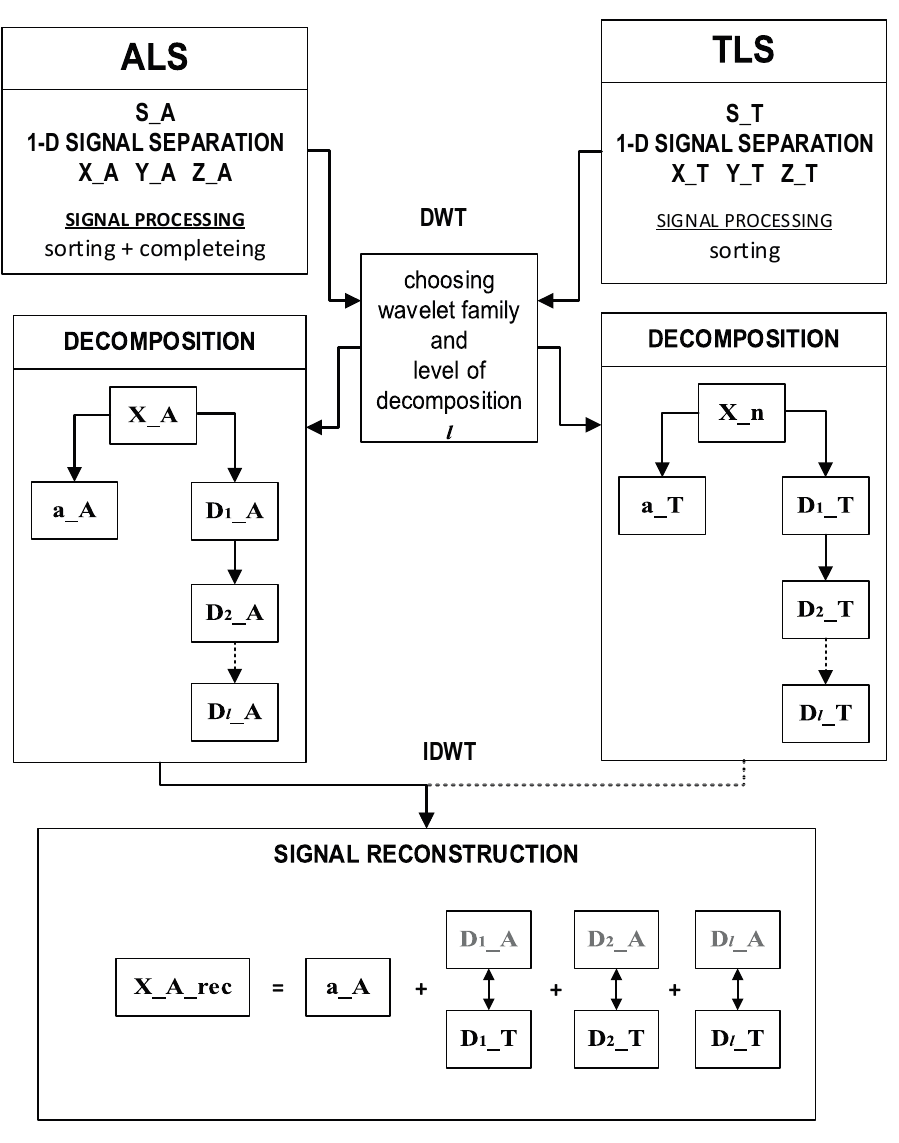
Figure 6. Detailed scheme of the